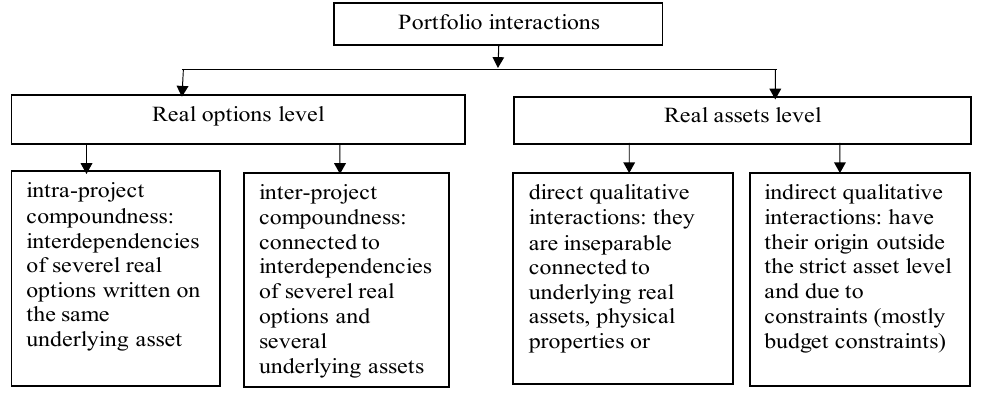
Fig. 1. Portfolio interactions (Trigeorgis,1993; Brosch,